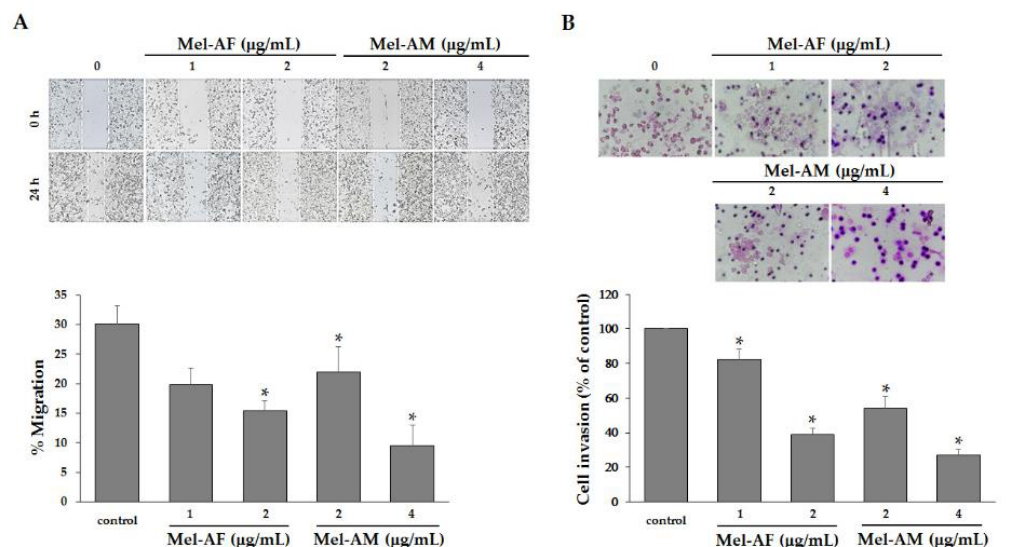
Figure 6. Mel-AF inhibited the migration and invasion activities of A375 cells. ( A ) Suppression of cell migration by Mel-AF was demonstrated using wound healing assay. Images depicting wounds at 0 and 24 h after treatment with Mel-AF (or Mel-AM) are shown (top). The gap distance was measured and the percentage of migration was calculated. ( B ) Decreases in cell invasion were determined by transwell invasion assay when compared with untreated cells (top). The percentage of cell invasion was calculated and compared with 100% cell invasion of the control. Data are presented as mean ± SEM values of three independent trials performed in triplicate. * p < 0.05 was determined by one-way analysis of variance.